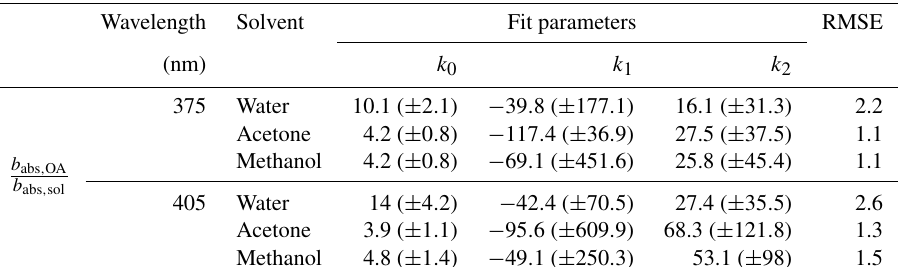
Table 1. Fit coefficients for b abs , OA /b abs , sol as a function of SSA ( y = k + k 1 ( SSA ) k 2 ) for tested solvents and the fuels analyzed in this study along with the RMSE value for each fit.